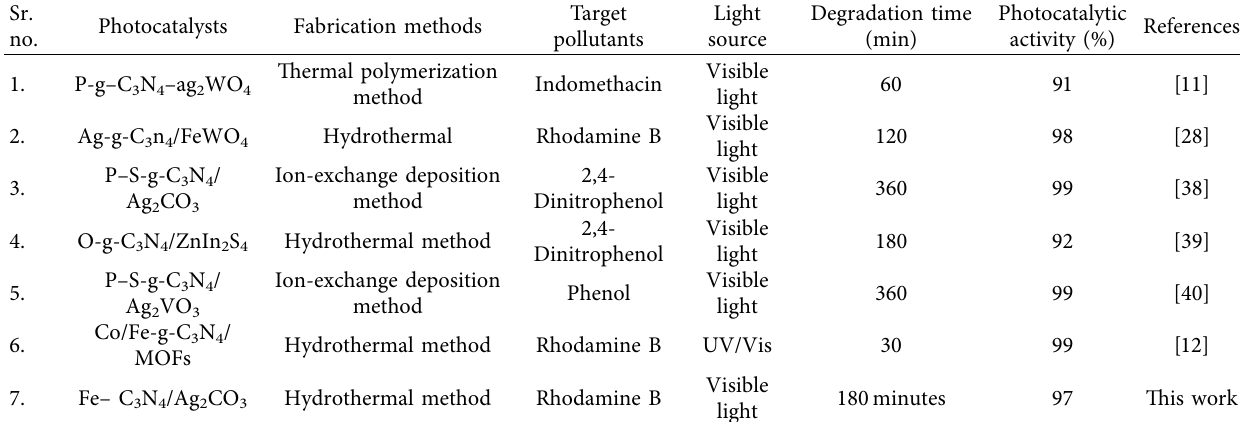
3 N 4 -based ternary photocatalysts.